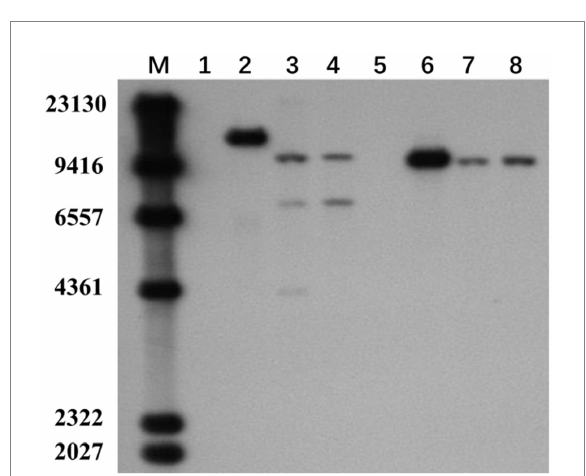
FIGURE 4 Southern blot assay of M. importuna transformants. M, maker. Lane1, untransformed M04M24 strain as negative control; Lane2, pEH2B plasmid as positive control; Lanes3, 4, randomly selected transformants of pEH2B; Lane5, untransformed M04M26 strain as negative control; Lane6, pMH2B plasmid as positive control; Lanes7, 8, randomly selected transformants of pMH2B. The numbers on the left indicate the base pair (bp) number of